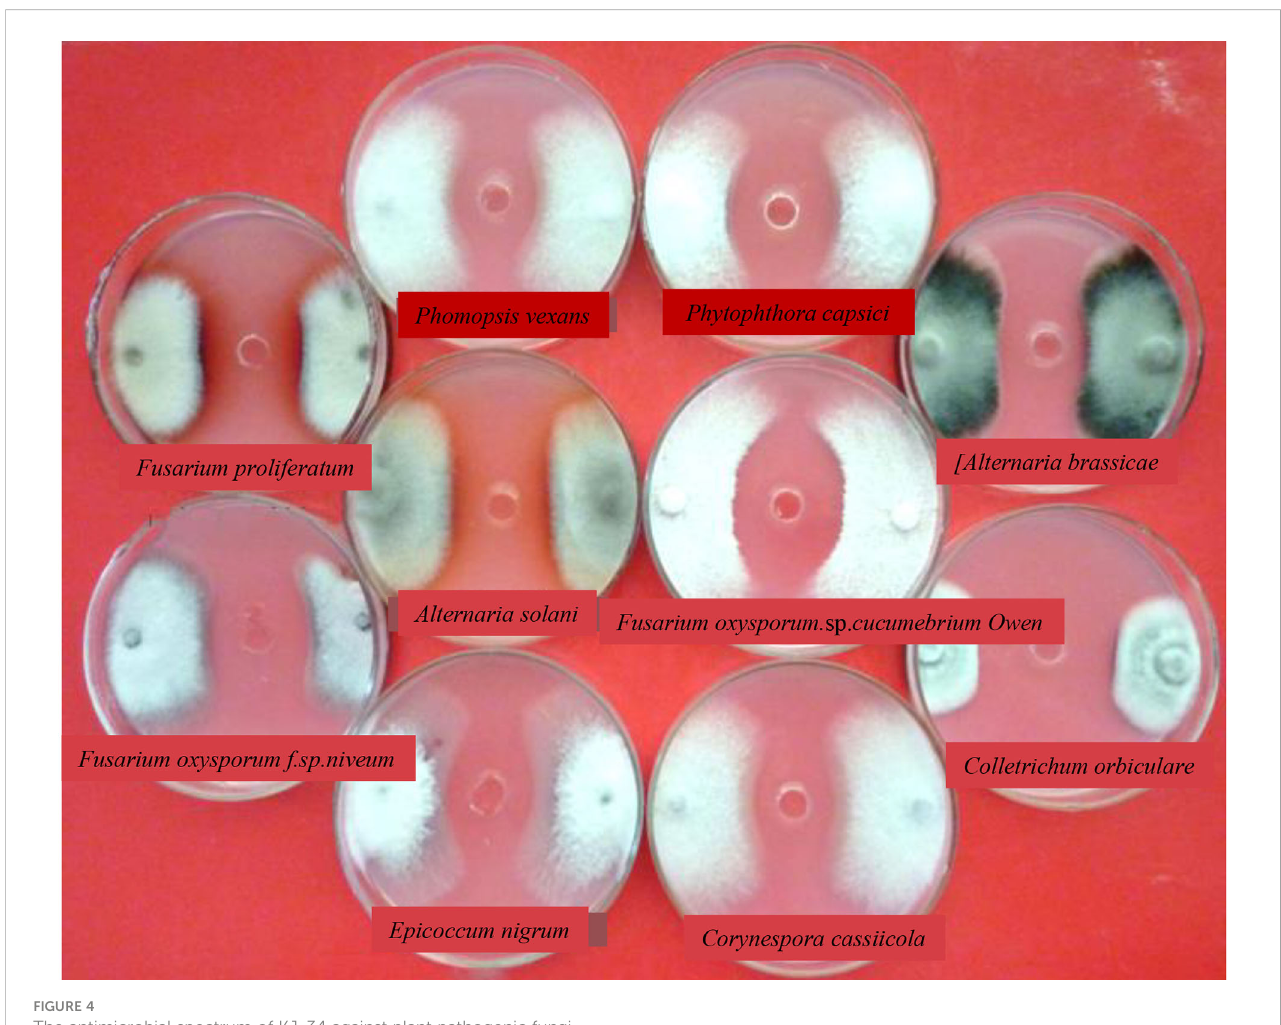
FIGURE 4 The antimicrobial spectrum of KJ-34 against plant pathogenic